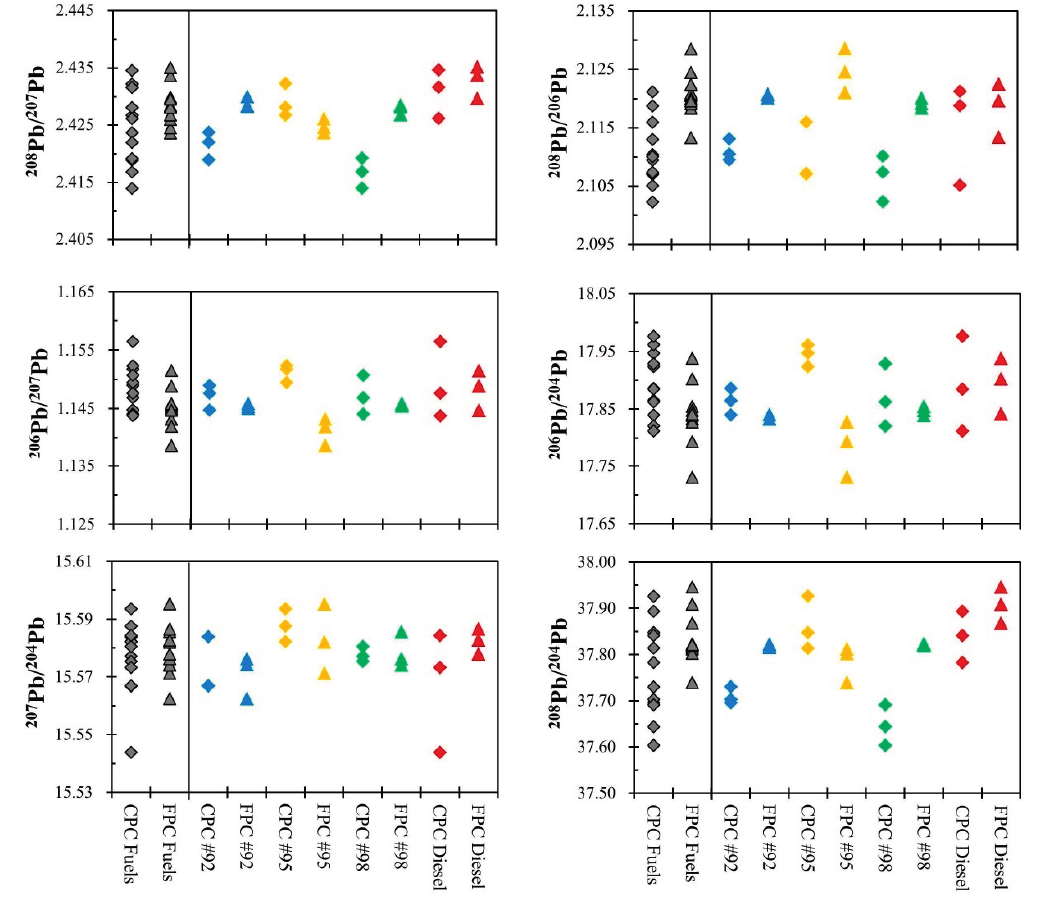
Figure 2. Lead isotopic ratios of Taiwan’s fuel products collected from Chinese Petroleum Corporation, Taiwan (CPC) and Formosa Plastics Corporation (FPC). Besides, #92, #95 and #98 represent unleaded gasoline with octane number 92, 95 and 98,